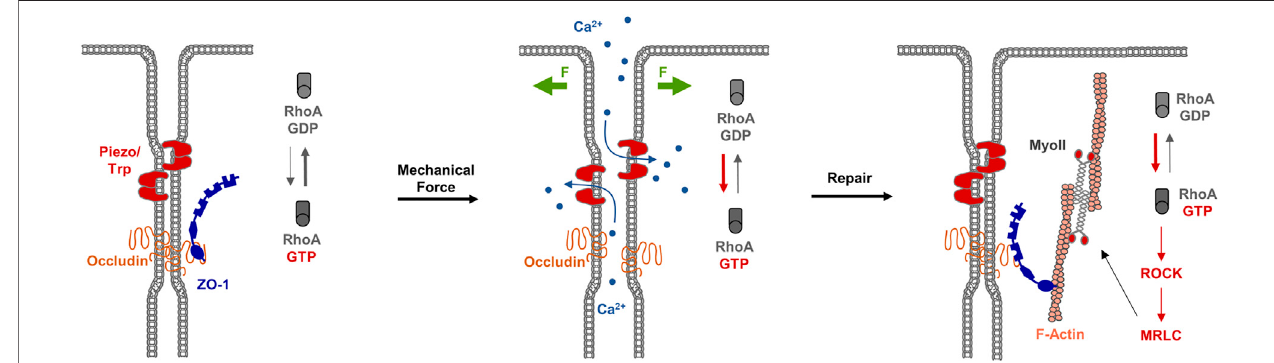
FIGURE 5 | RhoA fl ares repair TJ breaches. Left panel: Under steady state conditions, TJs form a functional barrier that prevents the free diffusion of small solutes along the paracellular pathway. Mechanosensitive receptors like Piezo or Transient Receptor Potential (TRP) channels are inactive. Middle panel: Mechanical forces (F, green arrows) trigger the activation of Piezo / TRP mechanosensitive Ca 2+ channels, which results in an in fl ux of Ca 2+ ions and the activation of the local pool of RhoA. Right panel: The local pool of active RhoA stimulates ROCK and MRLC resulting in actomyosi-based contractility and TJ